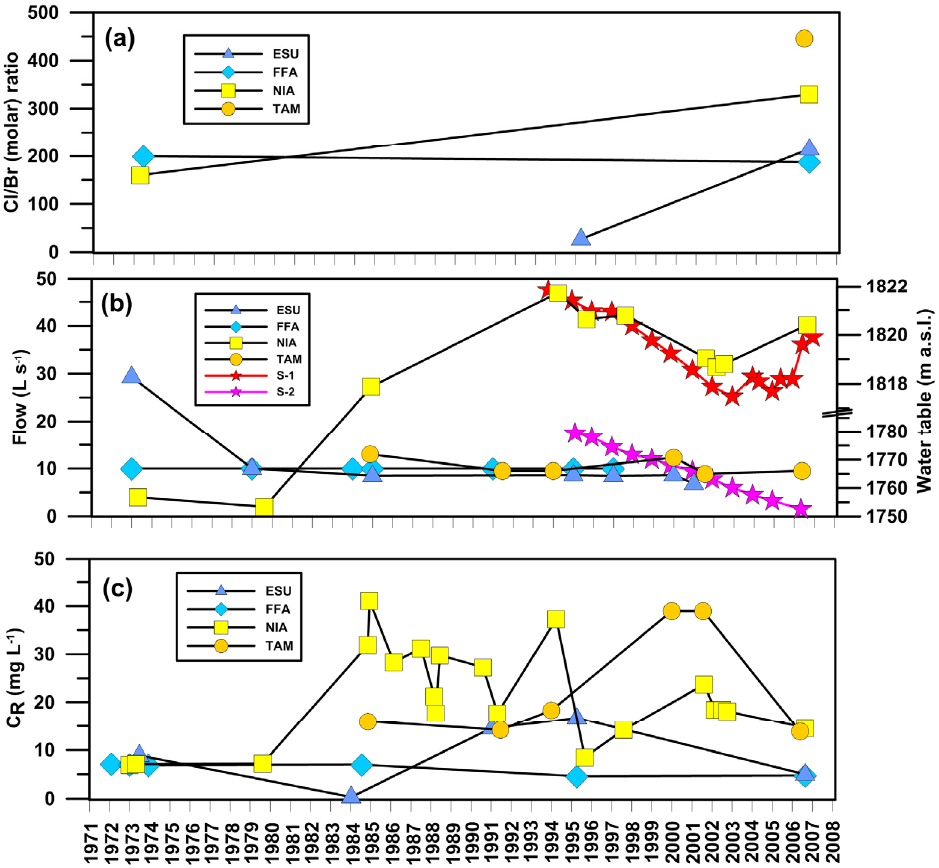
Figure 5. Temporal evolution of data in selected sampling points. ( a ) Cl/Br molar ratio; ( b ) Discharge flow (L·s − 1 ) in galleries and piezometric level (m a.s.l.) in S-1 and S-2 boreholes; and ( c ) C R (mg·L − 1 ) in galleries and boreholes S-1 and S-2. Data source: [30,33], and CIATFE hydrochemical database in